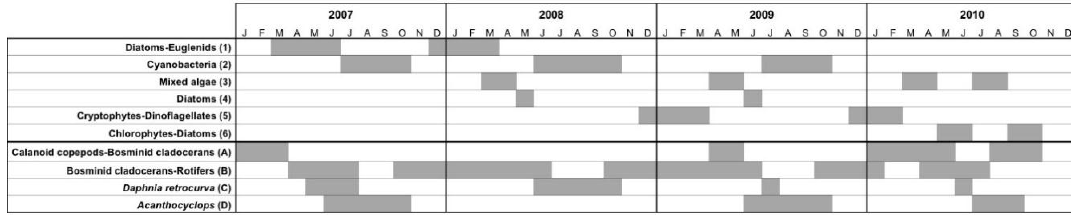
Figure 7. Seasonal succession of phytoplankton and mesozooplankton assemblage clusters identified from samples collected in Vancouver Lake between February 2007 and November 2010. Data from [61,62].